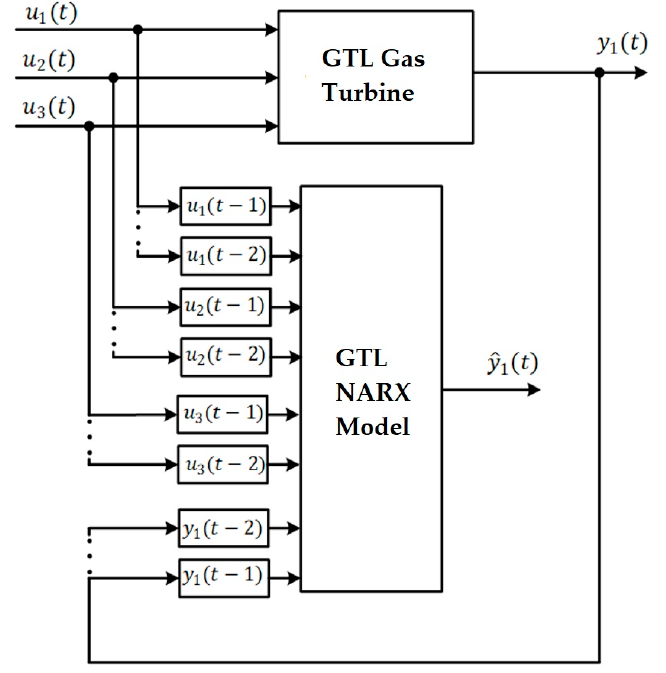
Figure 9. NARX model for the GTL. Figure 10 indicates the performance of the optimal NARX model (obtained with the proposed method), reaching an MSE of 1.9459 × 10 − 5 in epoch 17, an RMSE of 0.4411%, and a MAPE of 0.0643.